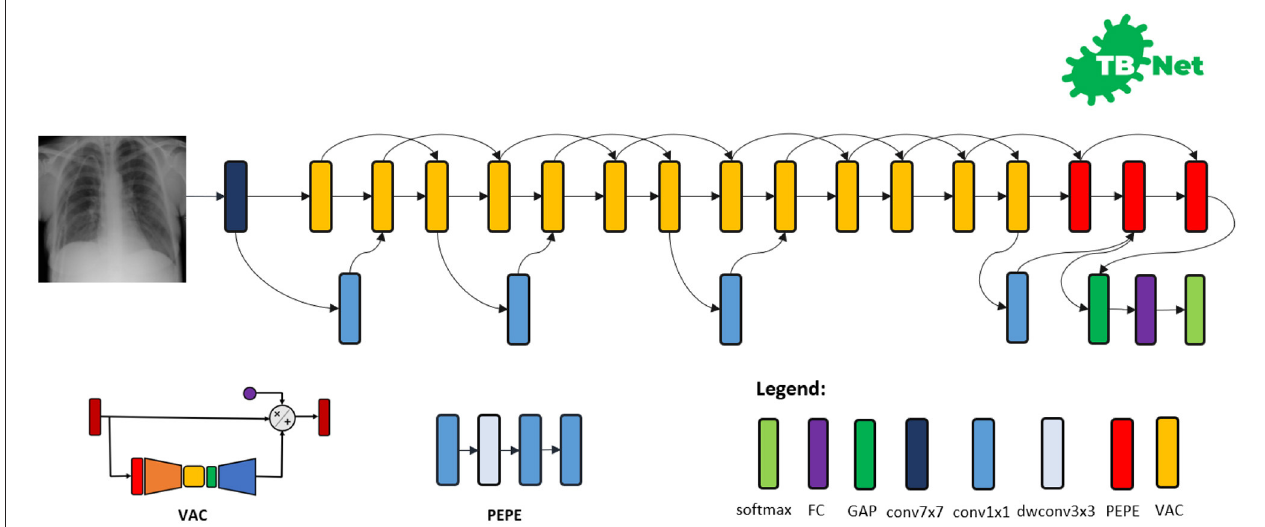
FIGURE 3 | The proposed TB-Net architecture design. The TB-Net design exhibits high architectural heterogeneity, light-weight design patterns, and the utilization of visual attention condensers, with macro-architecture and micro-architecture designs tailored specifically for the detection of TB cases from chest X-ray